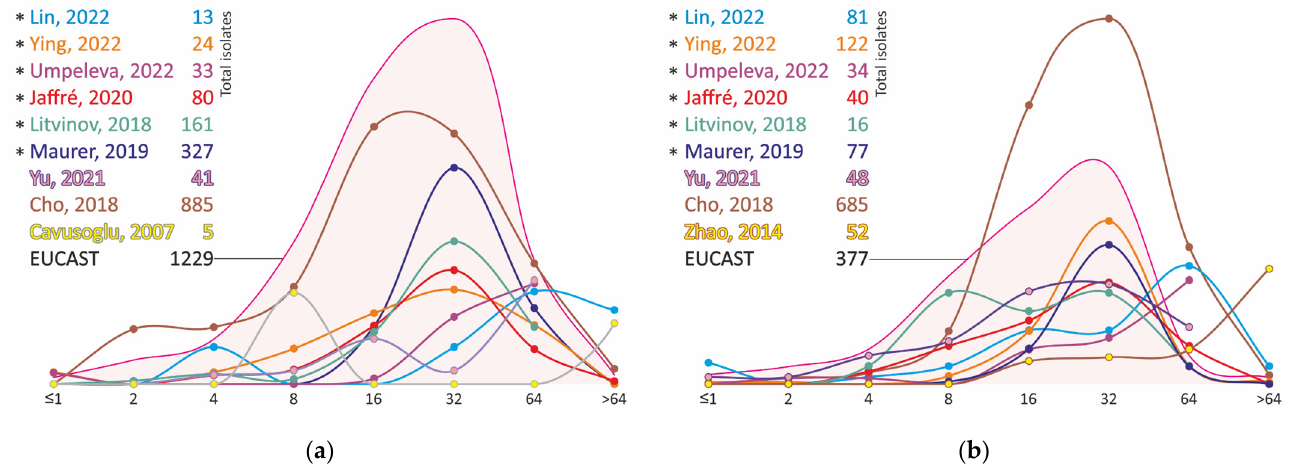
Figure 8. Linezolid MIC distribution for clinical M. avium ( a ) and M. intracellulare ( b ) isolates. *—MIC obtained using Sensititre SLOMYCO plates.